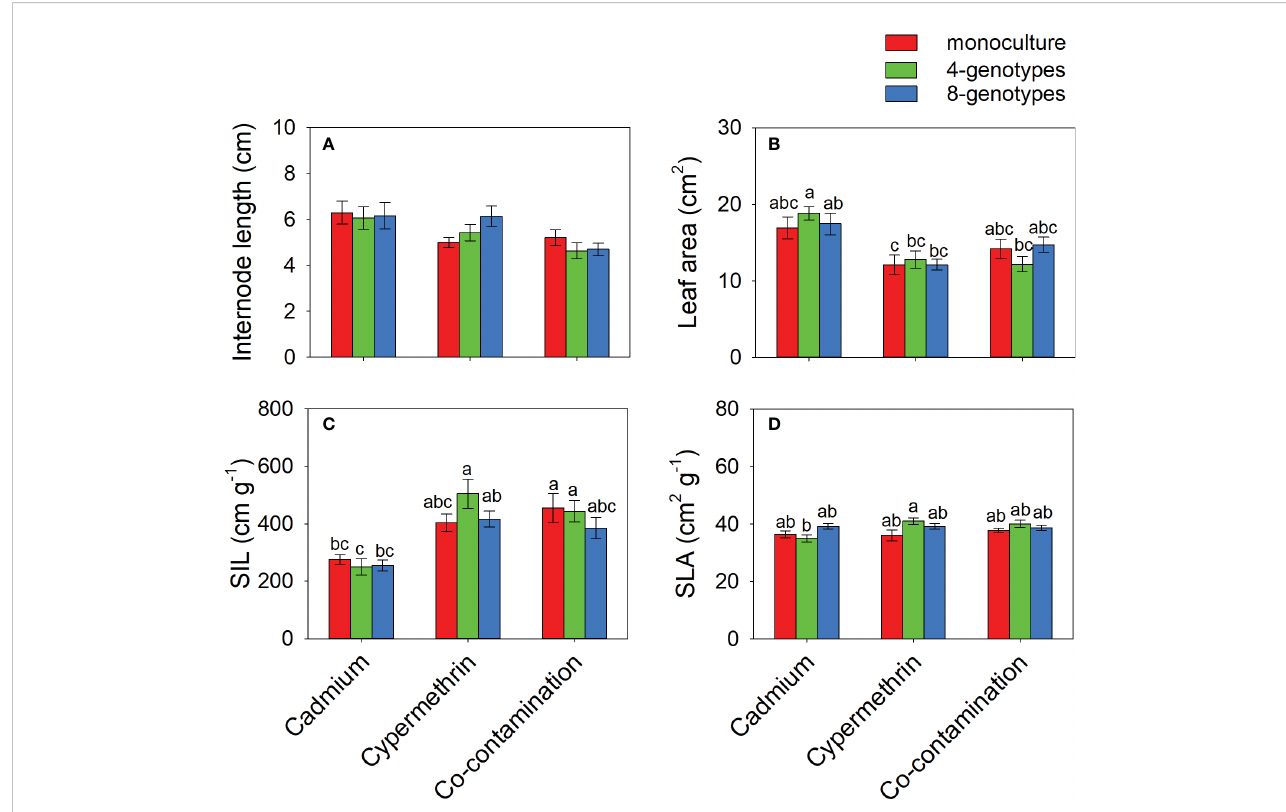
FIGURE 2 Internode length (A) , leaf area (B) , speci fi c internode length ( C ; SIL) and speci fi c leaf area ( D ; SLA) of Hydrocotyle vulgaris population consisting of different number of genotypes under different pollutant treatments. Mean values ( ± 1 SE) are presented. Letters (a-c) above the bars indicate signi fi cant differences ( P < 0.05) among each panel. See Table 1B for ANOVA